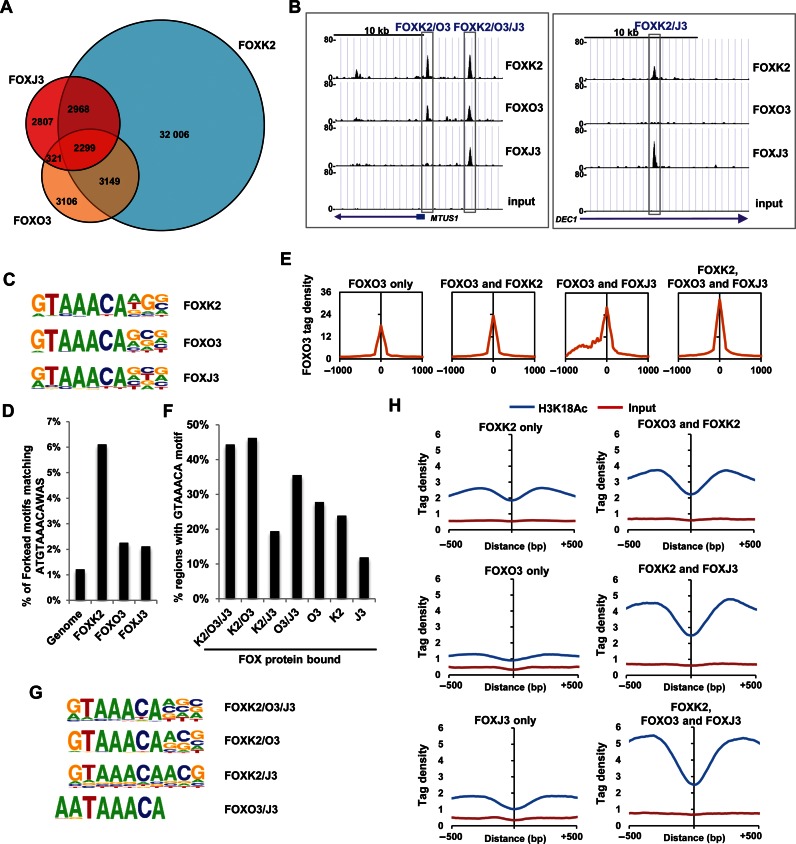
FOXK2, FOXO3 and FOXXJ3 exhibit extensive overlap in chromatin binding. (A) Venn diagram showing overlapping binding regions shared between FOXK2, FOXO3 and FOXJ3. If multiple peaks from a single FOX protein overlapped, they were merged to a single event. (B) UCSC genome browser views of FOXK2, FOXO3 and FOXJ3 binding profiles associated with the indicated loci illustrating binding regions shared between the indicated FOX proteins. (C) WebLogo representation of FOX motifs identified by de novo motif discovery in the FOXK2, FOXO3 and FOXJ3 binding regions. (D) Percentage of indicated binding peaks (±200 bp from the summit) that contain the ATGTAAACAAS motif. (E) Average tag densities surrounding the summits (±1 kb) of the FOXO3 binding regions, either uniquely or also associated with binding of the indicated additional FOX proteins. (F) Percentage of indicated classes of binding regions (±200 bp from the summit) that contain the core GTAAACA motif. (G) WebLogo representation of the top ranking FOX motifs identified by de novo motif discovery in regions bound by the indicated combinations of FOXK2, FOXO3 and FOXJ3. (H) Average tag densities (counted in 10 bp bins) of H3K18 acetylation surrounding the summits (±500 bp) of the regions associated with binding of the indicated FOX proteins.